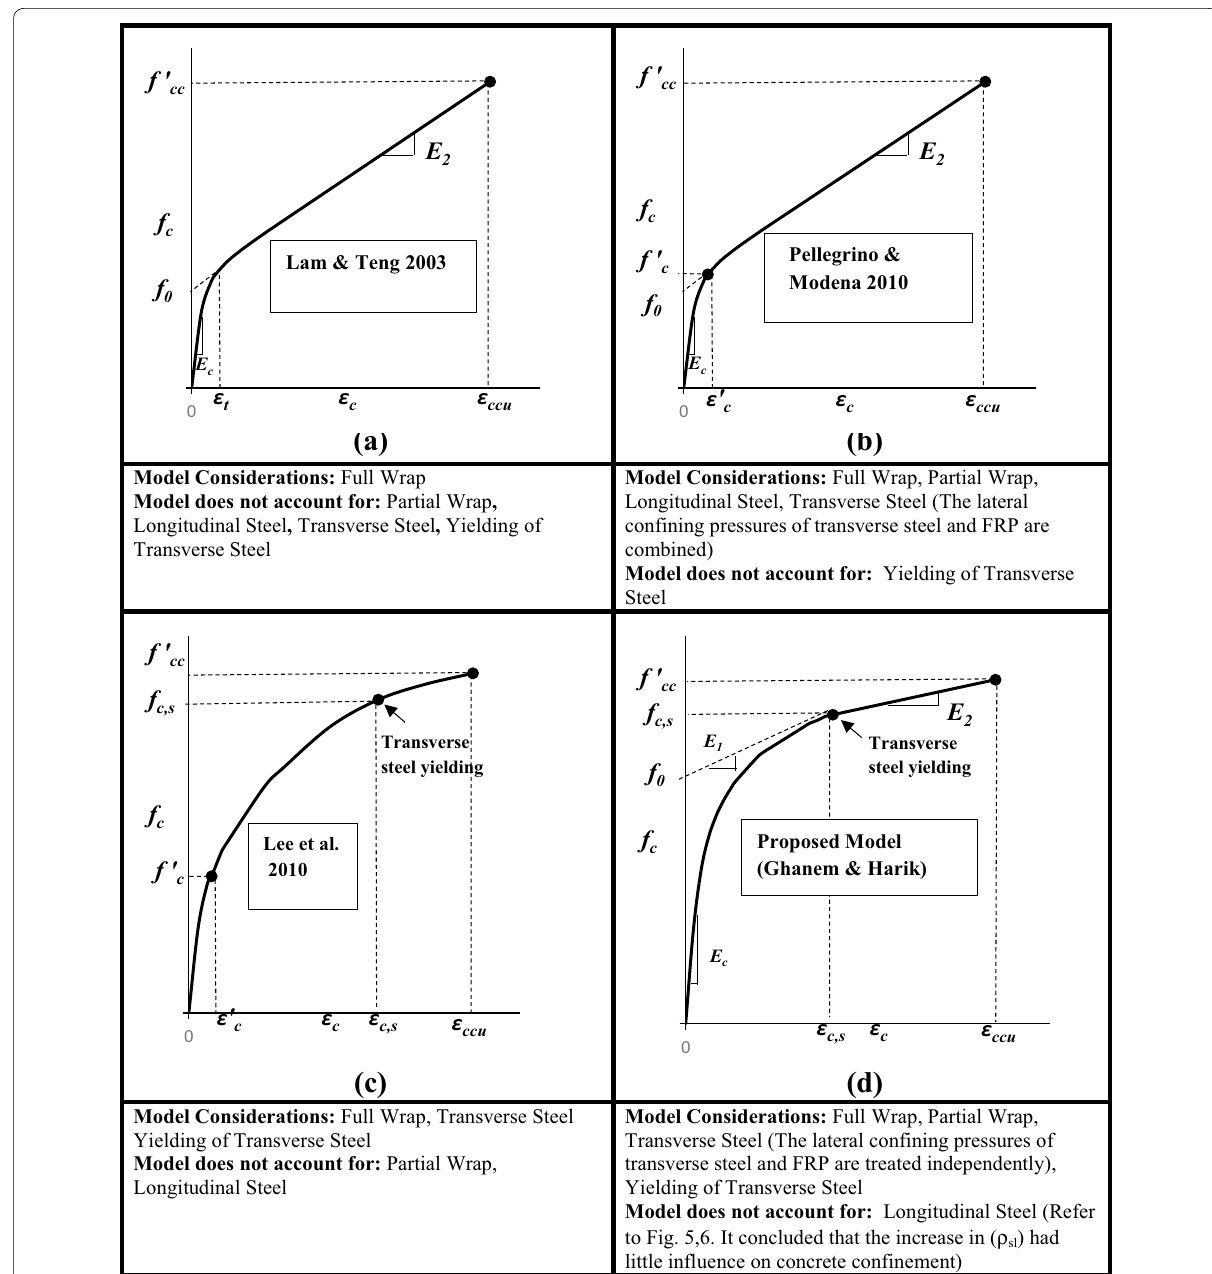
Fig. 8 Confined concrete stress-strain models: a Lam & Teng 2003 , b Pellegrino & Modena 2010, c Lee et al. 2010, and d Proposed